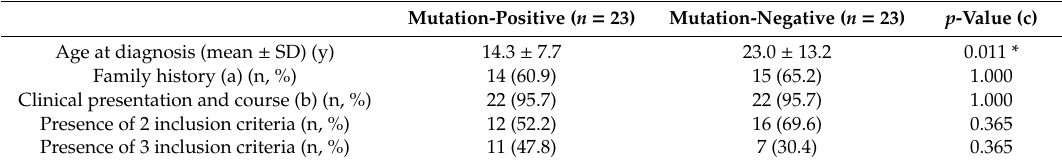
Table 3. Comparison of clinical characteristics of mutation-positive and mutation-negative